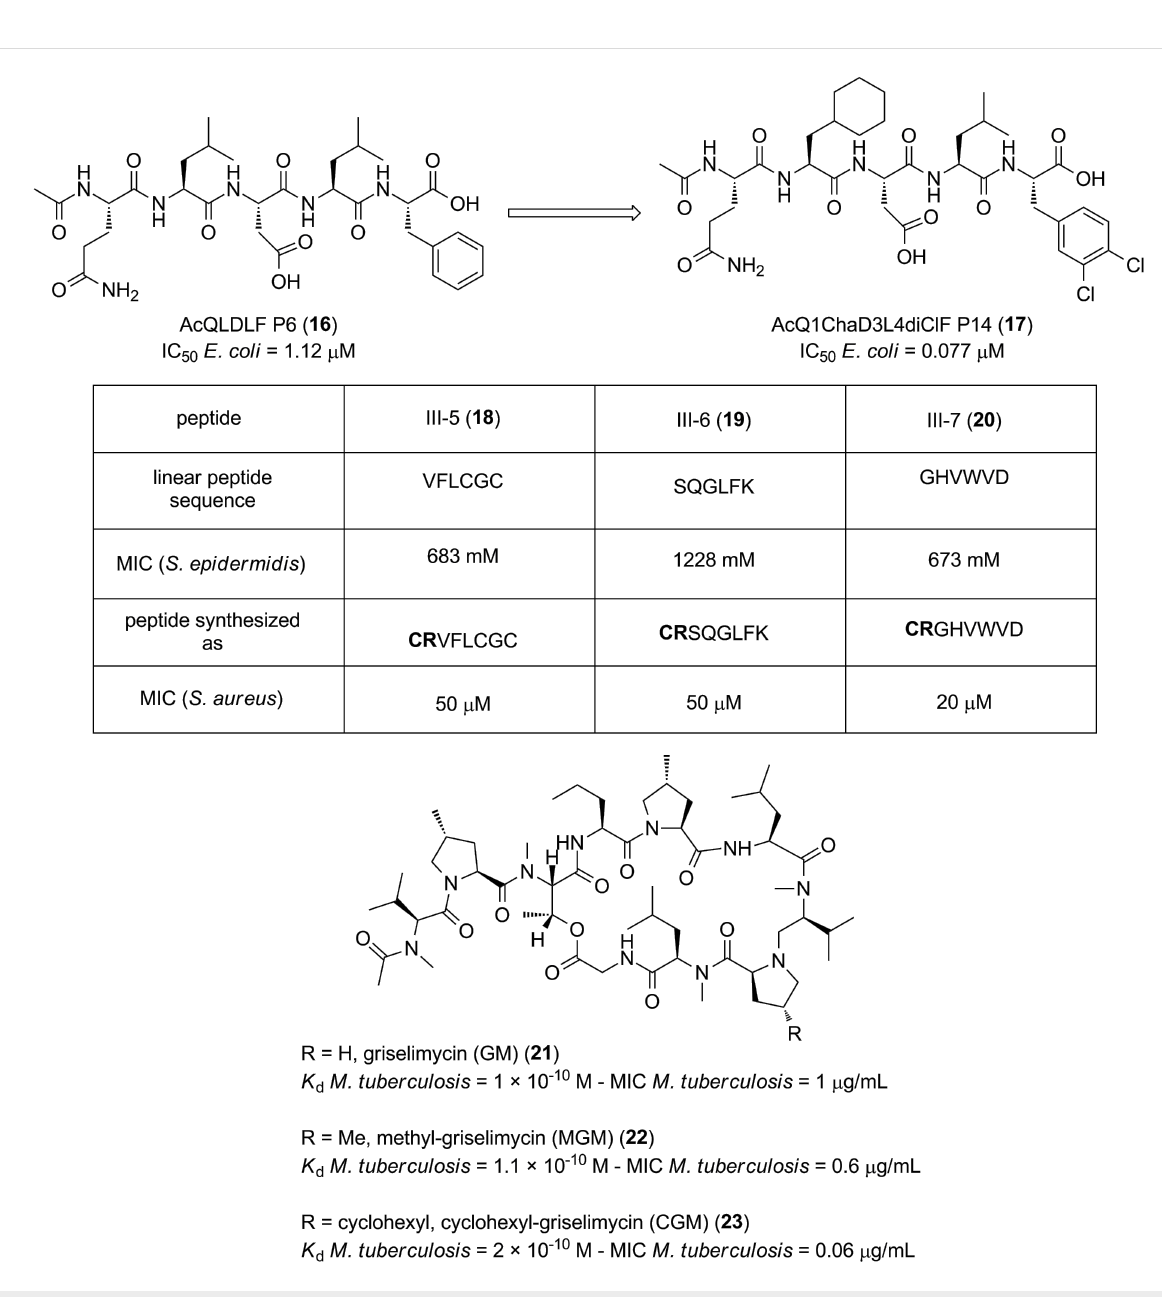
imp4213), Bacillus subtilis , Neisseria gonorrhoeae , Neisseria meningitidis and Neisseria lactamica [76]. As a result, the com- pounds were able to successfully inhibit the growth of some of the bacteria tested. The authors also determined the growth suppressive effects on model Gram-positive ( B. subtilis ) and Gram-negative ( E. coli imp4213) bacteria. The MIC values against B. subtilis were found to be 40, 11, 16 μ M for CFAM, BCBP and MPTA, respectively, while the MIC values against the membrane-compromised E. coli were found to be 36, 62 and 10 μ M,